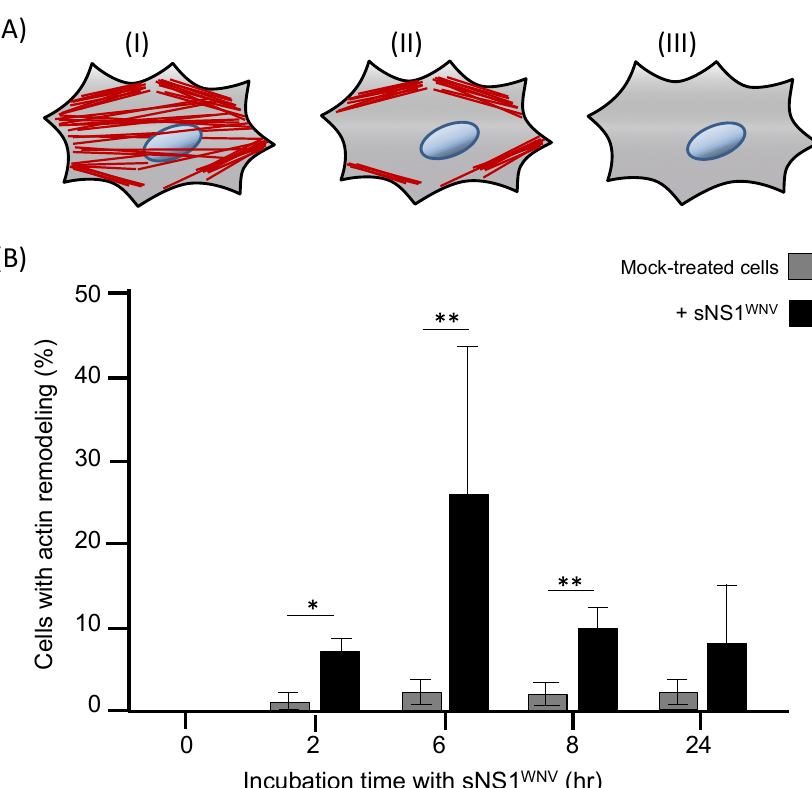
Figure 5. Kinetics of actin remodeling in sNS1 WNV -treated Vero E6 cells. Extracellular, soluble H 6 -tagged sNS1 WNV protein, released by pNS1 WNV-IS98 -transfected HEK-293T cells and purified by affinity chromatography, was added to the cell culture medium of Vero E6 cells, at a final concentration of 10 μg/mL. Control, mock-treated cells consisted of cells incubated with samples from the culture medium of HEK-293T cells transfected with empty plasmid pcDNA3.1, subjected to the same chromatographic process as the culture supernatant of pNS1 WNV-IS98 -transfected cells. At different times of incubation with sNS1 WNV at 37 °C (0 to 24 h), cells were fixed and stained with rhodamine–phalloidin. ( A ) Schematic representation of cells grouped according to different F-actin morphologies. ( I ) Cells with organized actin fibers, as observed in the majority of mock-treated cells. ( II ) Cells showing reduced number of organized actin filaments, and notably the absence of perinuclear actin network. ( III ) Cells showing total absence of actin filaments. ( B ) Cell counts. Cells with alterations of the actin network as defined above were counted using the ImageJ program, and the results of groups (II) and (III) were pooled and expressed as the percentage of the total number of cells examined per field. A total of 140–330 individual cells were examined by fluorescence microcopy in at least 5–10 separate microscopic fields. Data presented in the bar graph are mean values ( m ± SD ) obtained from three separate experiments. Statistical analyses were performed using the Mann–Whitney test, with p ≤ 0.05 (*); p ≤ 0.01 (**).